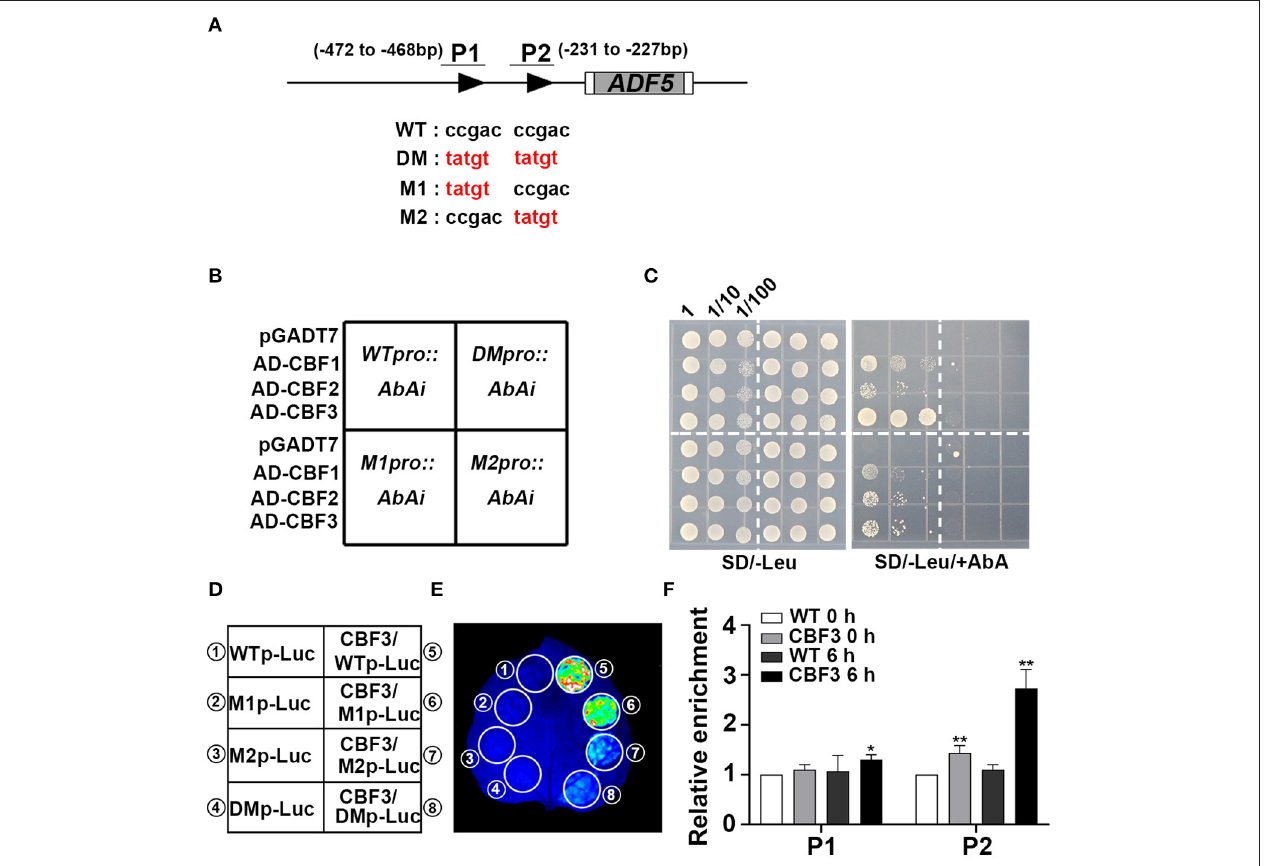
FIGURE 3 | CBFs activate ADF5 expression via direct binding to the ADF5 promoter. (A) Schematic diagram of the CRT/DRE DNA regulatory element of the ADF5 promoter. The black triangle represents the CRT/DRE DNA regulatory element. M1 is a mutation at the − 472 to − 468 bp sites. M2 is a mutation at the − 231 to − 227 bp sites. DM is a simultaneous mutation of M1 and M2. P1 and P2 are specific primers for ChIP assay. (B) Diagram of Y1H colony. (C) Y1H assay of the interaction between CBFs and the ADF5 promoter showing the growth of yeast cells on SD/-Leu medium containing 850ng/mL Aureobasidin A (AbA). The numbers above the images indicate the dilutions. (D) Schematic diagram of the transcriptional activation experiment. (E) CBF3 activates the expression of ADF5 in tobacco leaves via transient expression. (F) ChIP analysis of the interaction between CBFs and the ADF5 promoter under normal conditions or 4 ◦ C for 6h. P1 contains − 472 to − 468 bp sites of the CRT/DRE DNA regulatory element. P2 contains − 231 to − 227 bp sites of the CRT/DRE DNA regulatory element. Data presented are the means ± SD of three independent biological replicates (* P < 0.05; ** P < 0.01; Student’s two-tailed t